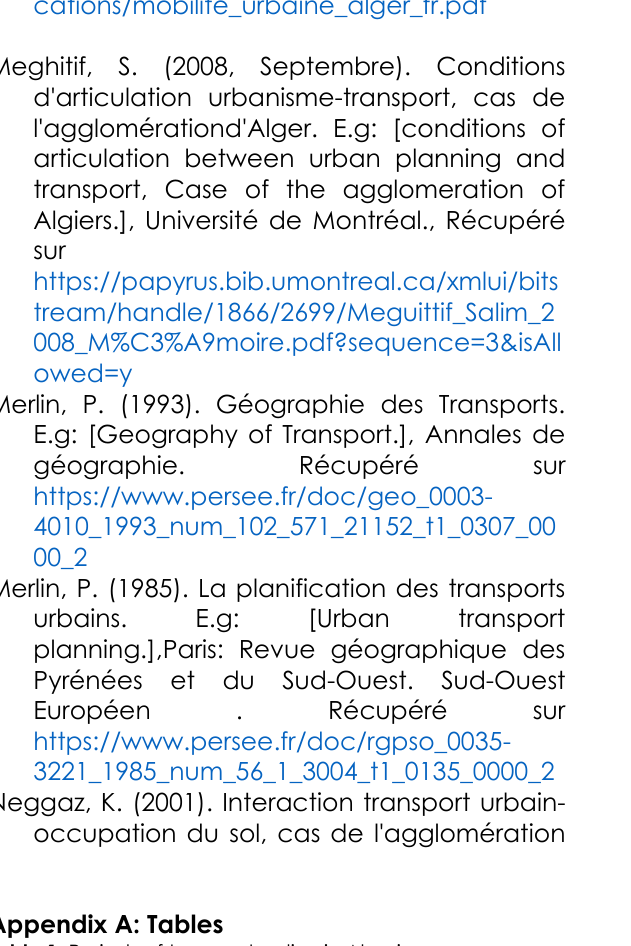
Table 1. Periods of transport policy in